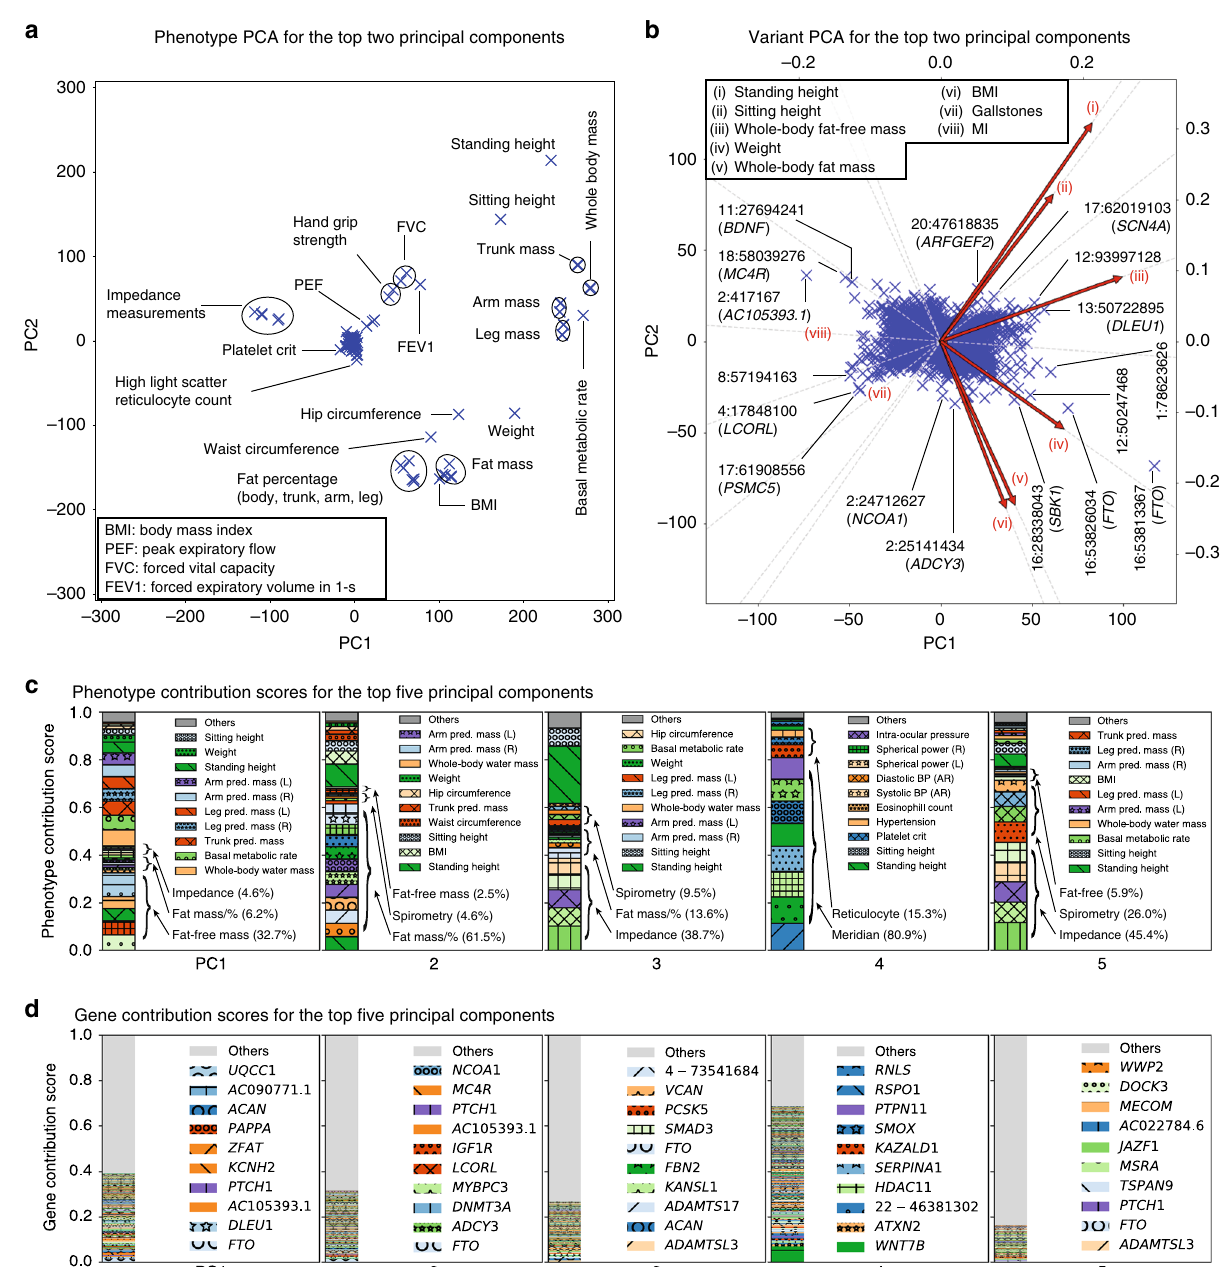
Fig. 2 Characterization of DeGAs latent structures. a , b Components from truncated singular value decomposition (TSVD) corresponds to principal components in the phenotype ( a ) and variant ( b ) spaces. The fi rst two components of all the variants, excluding the MHC region, and relevant phenotypes are shown. b For variant PCA, we show biplot arrows (red) for selected phenotypes to help interpretation of the direction of principal components (Methods). The variants are labeled based on the genomic positions and the corresponding gene symbols. For example, "16:53813367 ( FTO )" indicates the variant in gene FTO at position 53813367 on chromosome 16. c , d Phenotype ( c ) and gene ( d ) contribution scores for the fi rst fi ve components. PC1 is driven by largest part of the body mass that accounts for the “ healthy part ” (main text) including whole-body fat-free mass and genetic variants on FTO and DLEU1 , whereas PC2 is driven by fat-related measurements, PC3 is driven by bioelectrical impedance measurements, PC4 is driven by eye measurements, and PC5 is driven by bioelectrical impedance and spirometry measurements along with the corresponding genetic variants (main text, Supplementary Table 2, Supplementary Data 2). Each colored segment represents a phenotype or gene with at least 0.5% and 0.05% of phenotype and gene contribution scores, respectively, and the rest is aggregated as others on the top of the stacked bar plots. The major contributing phenotype groups (Methods, Supplementary Table 2) and additional top 10 phenotypes and the top 10 genes for each component are annotated in c and d , respectively. pred.: predicted, %: percentage, mass/% mass and percentage, BP: blood pressure, AR: automated reading, L: left, R: right. Source data are provided as a Source Data fi